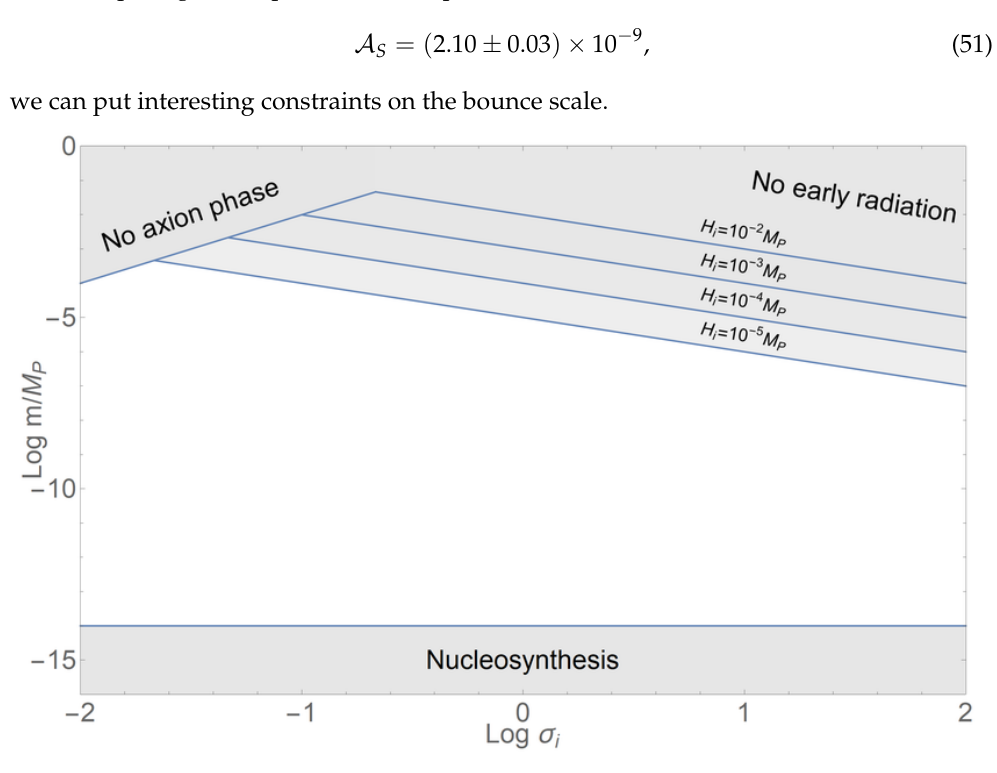
Figure 1. Allowed parameter space in the plane defined by the initial value of the axion in Planck units σ i and its mass m . Several lines are drawn depending on the chosen bounce scale H i